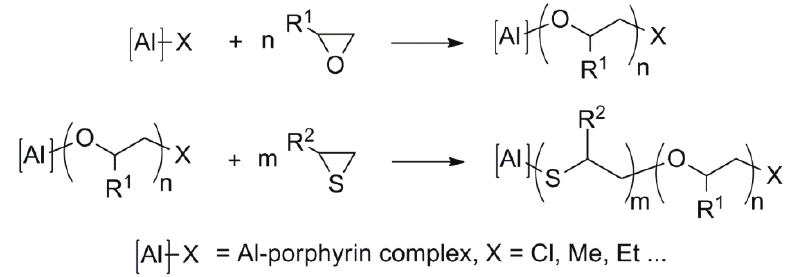
Figure 61. Synthesis of a block copolymer via a living ring-opening polymerization.